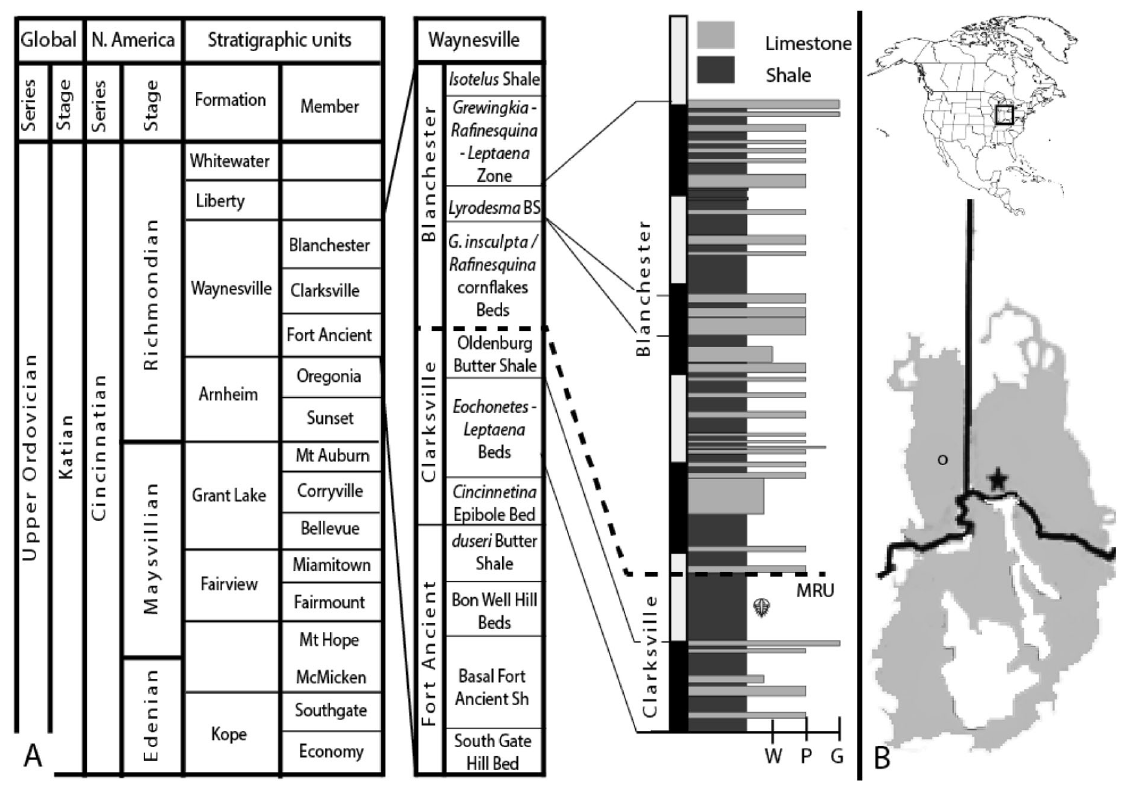
Fig. 1. A , generalized stratigraphic column of the Cincinnatian with a focus on the Waynesville Formation exposed near Oldenburg, Indiana. The dashed line indicates the location of the Mid-Richmondian Unconformity (MRU) in the section. The trilobite indicates the location of the Oldenburg butter shale (BS). The scale bar is in meters. B , map of the Ohio(cid:150)Kentucky(cid:150) Indiana tri-state with the Cincinnatian rocks marked in gray. The star represents Cincinnati and the (cid:147)o(cid:148) indicates the approximate location of Oldenburg, Indiana. W = wackestone, P = packstone, G =